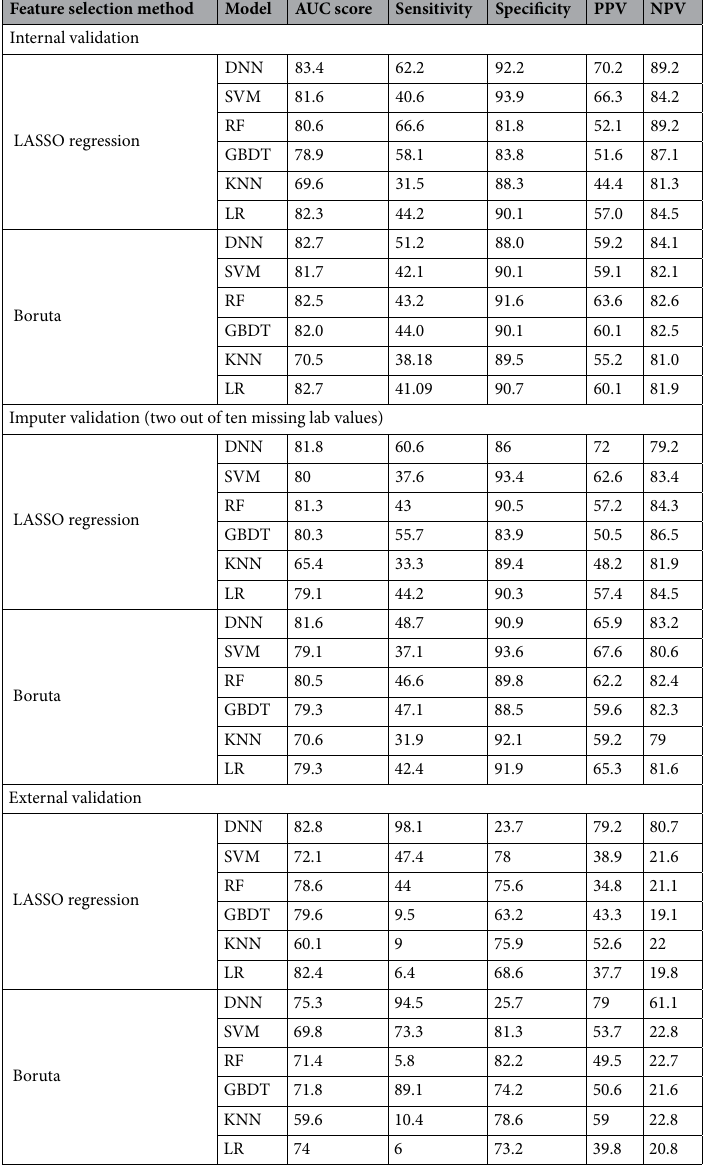
Table 3. Model internal and external validation; and validation of imputer model for 2 out of 10 missing lab value. DNN deep neural network, SVM supervector machine, RF random forest, GDBT gradient booster decision tree, KNN k-nearest neighbor, LR logistic